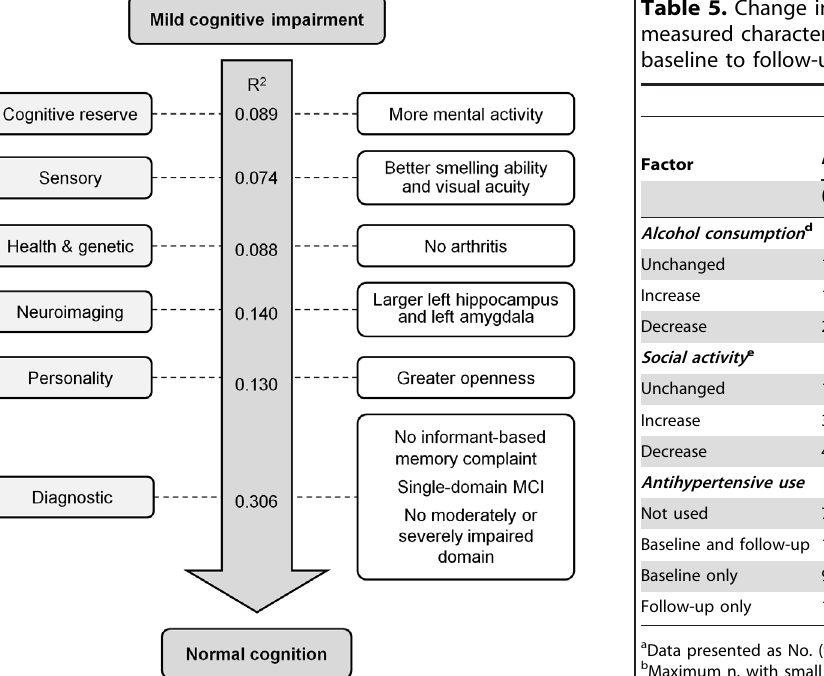
Table 4. Potentially modifiable continuously-measured characteristics of reverters and non-reverters at baseline and follow-up a .